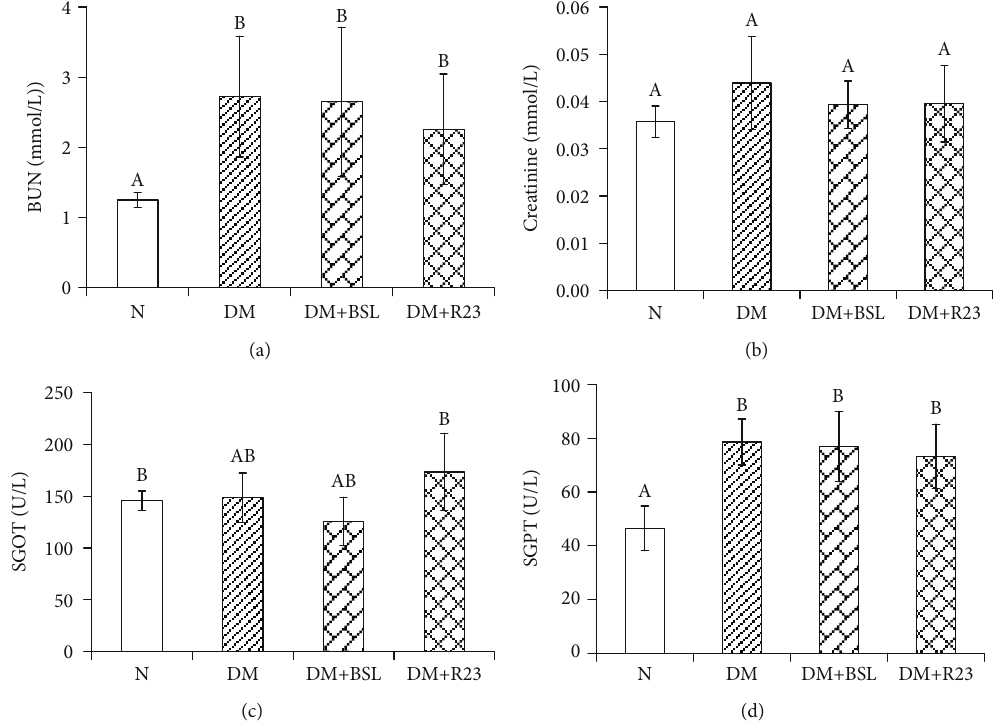
Figure 4: E ff ect of L. rhamnosus BSL and L. rhamnosus R23 on renal and liver biomarker in experimental groups after intervention period for 30 days. The values are expressed as the means ± SD ( n = 6 ). The values with di ff erent superscript letters are signi fi cantly di ff erent ( P < 0 : 05